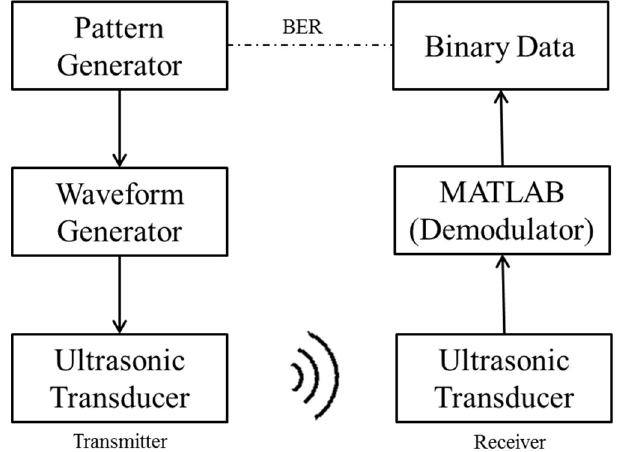
Figure 10. Workflow of signal processing.